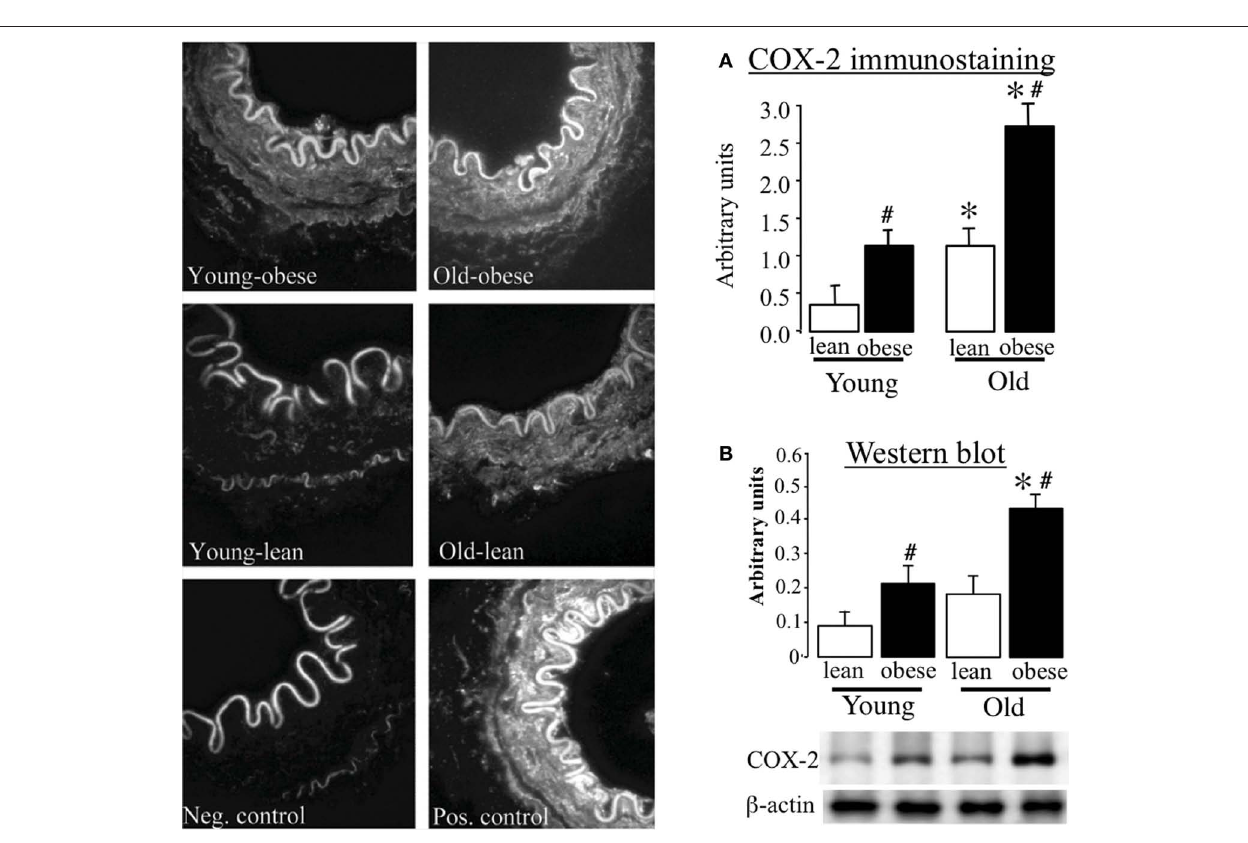
Figure 5 | (A) Detection of COX2 in mesenteric resistance arteries isolated from young or old lean and obese Zucker rats using immunostaining and confocal microscopy. A negative control was obtained by omitting the primary antibody (Neg. control) and a positive control was obtained using arteries from